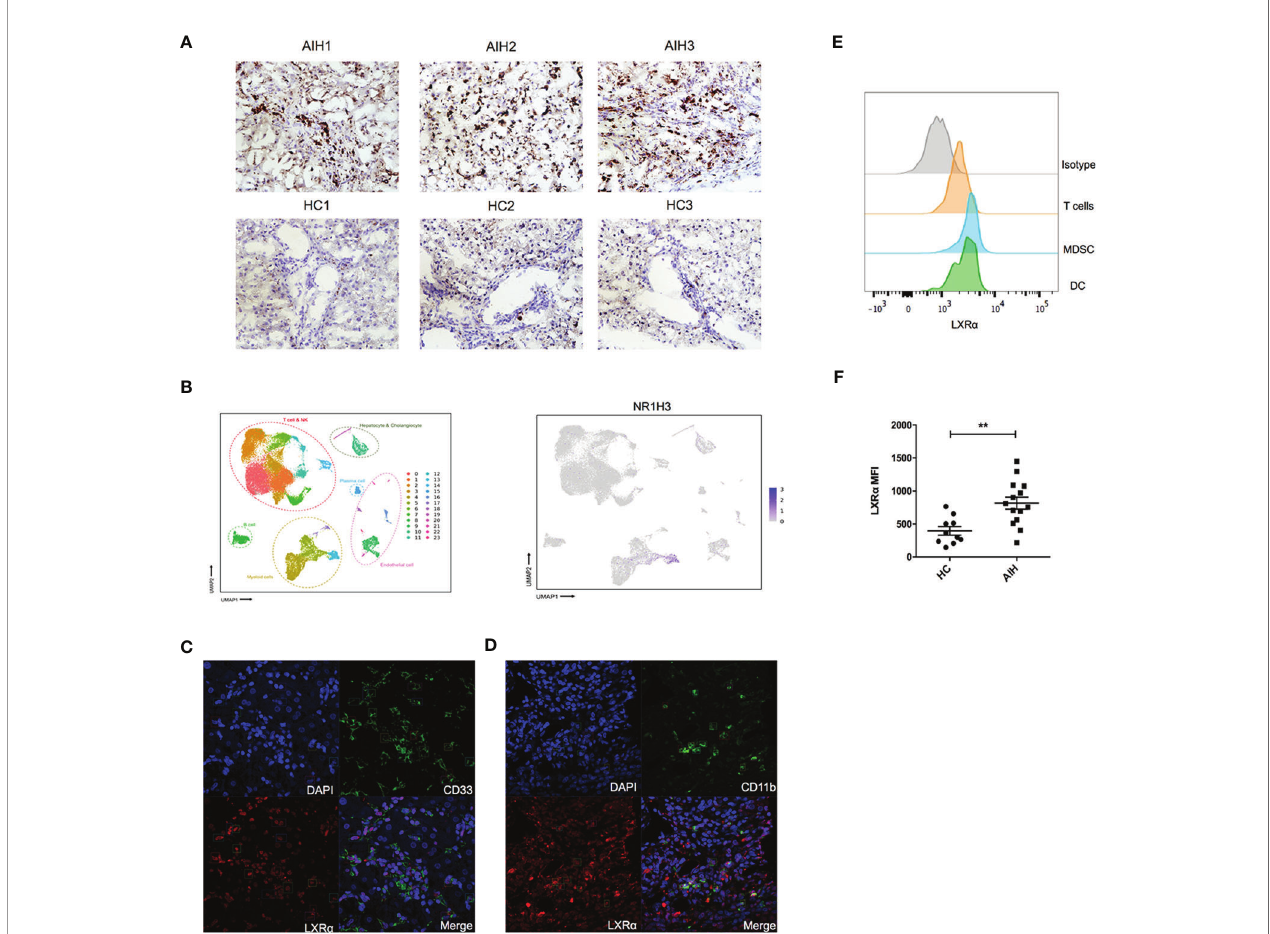
FIGURE 1 | Expression of LXR a was elevated in the liver of AIH and colocalized with MDSCs. (A) Representative immunohistochemistry staining of LXR a (×100) in the frozen liver sections of patients with AIH and healthy controls. (B) Single-cell sequencing data (GSE136103) of hepatic nonparenchymal cells showed that LXR a is highly expressed by myeloid cells. Confocal microscopy demonstrated the colocalization of the MDSC markers CD33 (C) and CD11b (D) with LXR a using liver tissue of AIH patients. (E) Expression of LXR a in the peripheral CD3 + T lymphocytes, HLA-DR − /lo CD11b + CD33 + MDSCs, and CD11c + HLA-DR + DCs of AIH patients and healthy controls was detected by fl ow cytometry. (F) Mean fl uorescence intensity (MFI) of LXR a in peripheral blood mononuclear cells of AIH patients ( n = 14) and healthy donors ( n = 10) was calculated by MFI of LXR a minus MFI of isotype antibody. The AIH patients who provided peripheral blood were newly diagnosed and have not received treatment of steroid. Data are presented as mean ± SEM. ** p <